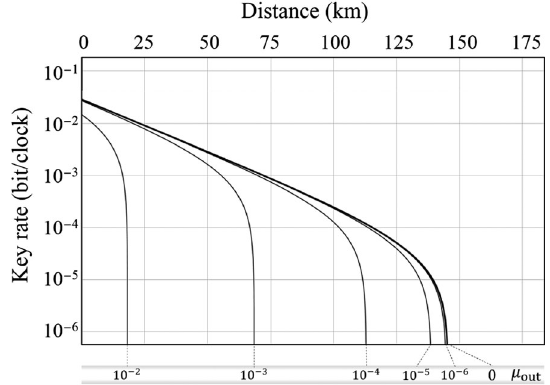
~ R (cid:4)(cid:4) FIG. 11. Asymptotic key rate versus distance for the decoy- state efficient BB84 protocol, under a THA with unambiguous state discrimination by Eve. The rate is plotted for various values of the parameter μ . Parameters in the simulation are as in Fig. out